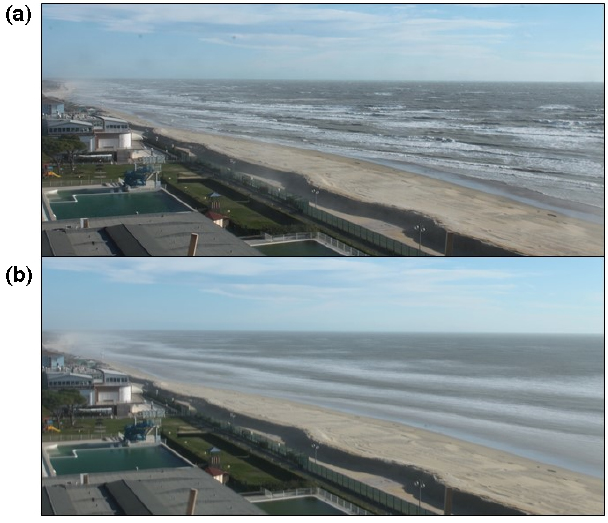
Figure 3. Examples of a snapshot image (a) and a timex image (b) in Jesolo